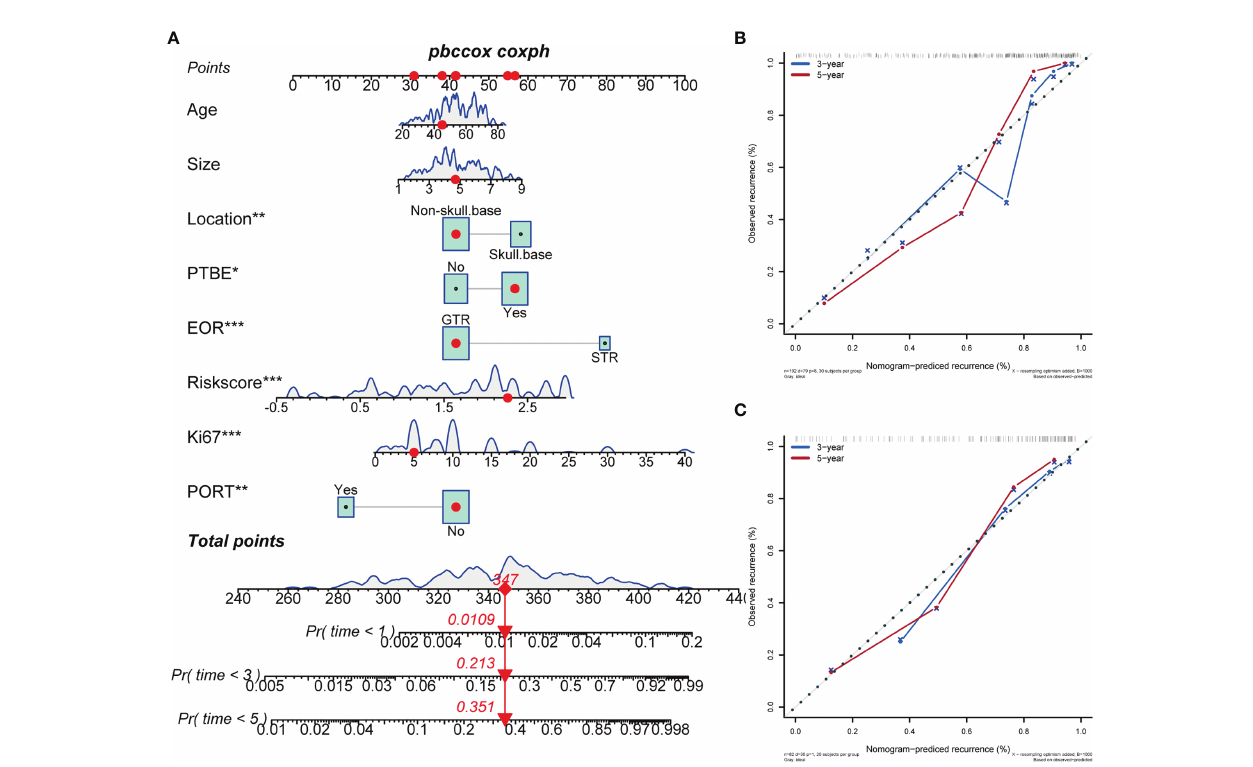
FIGURE 2 | A nomogram constructed based on hematological parameters and clinical prognostic factors predicts the progression of WHO grade II meningiomas. The continuous variable curves represent the data distribution trends of continuous covariates in this study; the box area represents the proportion of categorical variables in the overall data. The nomogram score is the total score obtained by summing the risk scores of the eight covariates. The 1-year, 3-year, and 5-year tumor progression probabilities of each patient are the value on the probability scales corresponding vertically to the nomogram score. (A) Nomogram in WHO grade II meningiomas. (B) Calibration curves of the Nomogram at 3- and 5-years in the training cohort. (C) Calibration curves of the Nomogram at 3- and 5-years in the test cohort. *P > 0.01 and P < 0.05; **P > 0.001 and P < 0.01; ***P <